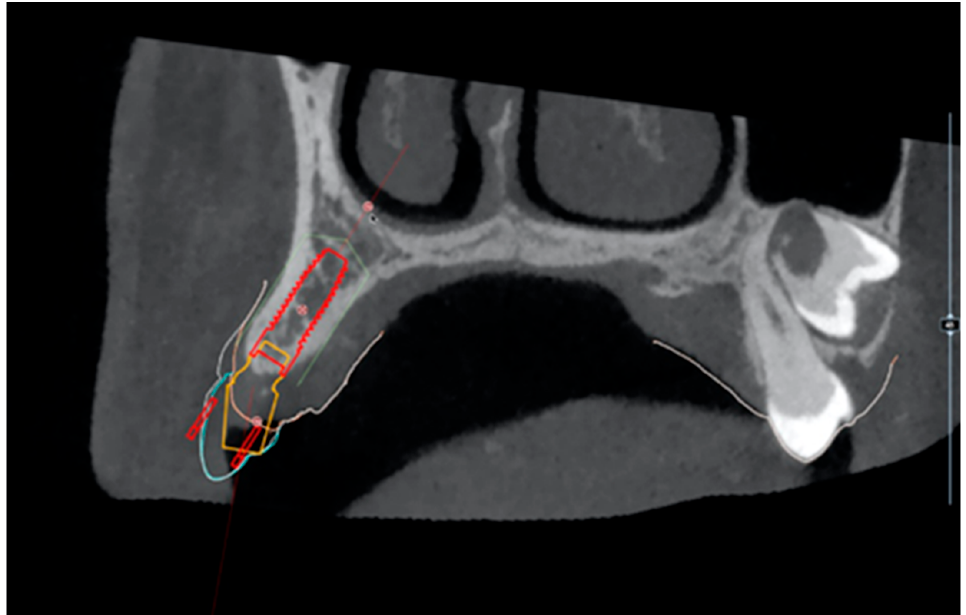
Figure 2. Guided implant planning in zone 1.3 using CBCT, the soft tissue contour, and the digital wax-up. Computer-guided planning of abutment angulation was made according to the digital diagnostic wax-up of the 1.3 element.